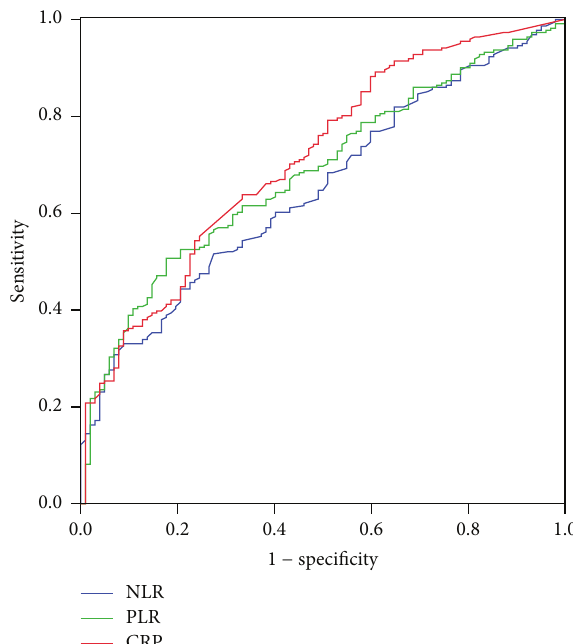
Figure 3: ROC curves for CSS prediction. The area under the curve (AUC) was 0.713 (95% CI: 0.653–0.772, 𝑃 < 0.001 ) for CRP, 0.650 (95% CI: 0.589–0.711, 𝑃 < 0.001 ) for NLR, and 0.685 (95% CI: 0.626–0.744, 𝑃 < 0.001 ) for PLR.